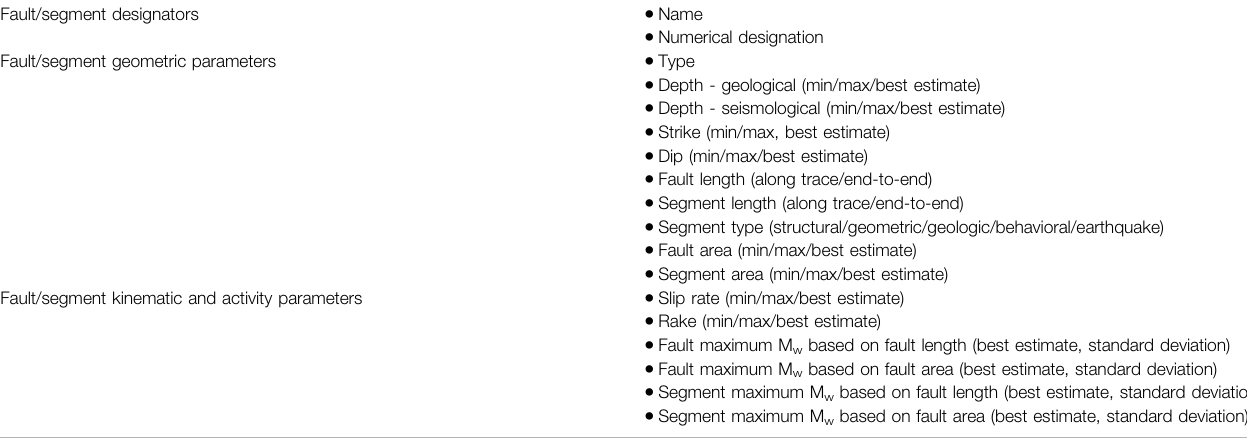
TABLE 1 | List of designators and seismotectonic parameters for each fault and fault segment in the database. Fault/segment designators Fault/segment geometric parameters